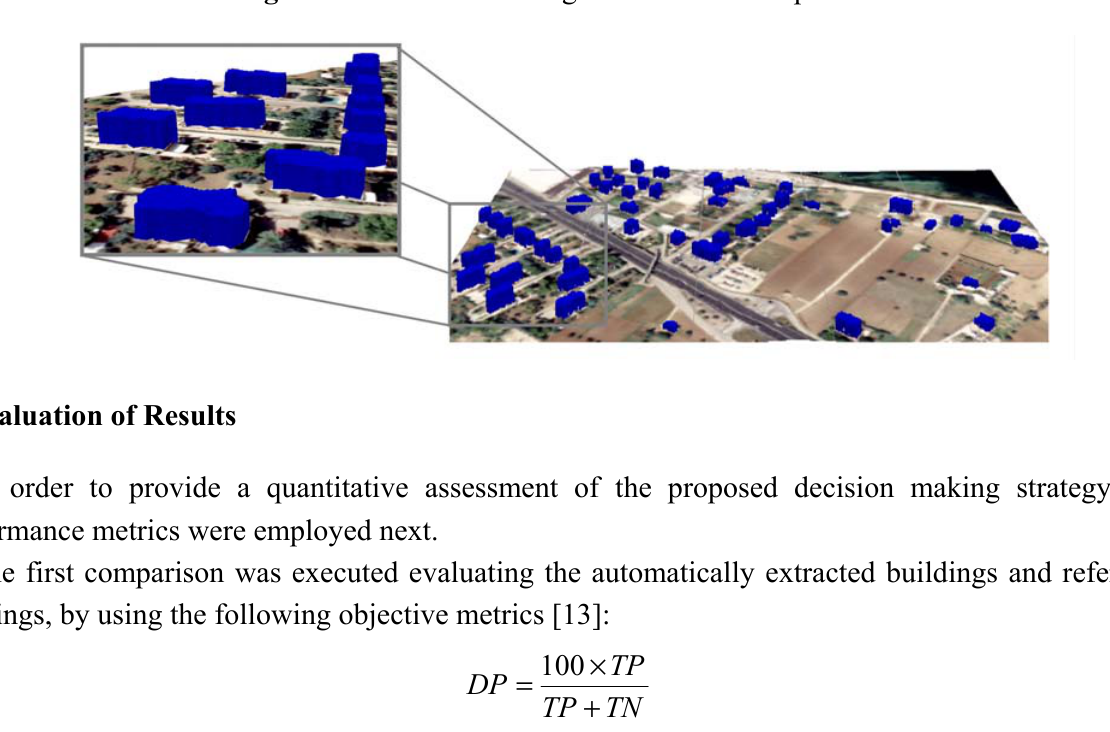
Figure 5. Extruded buildings on the raw